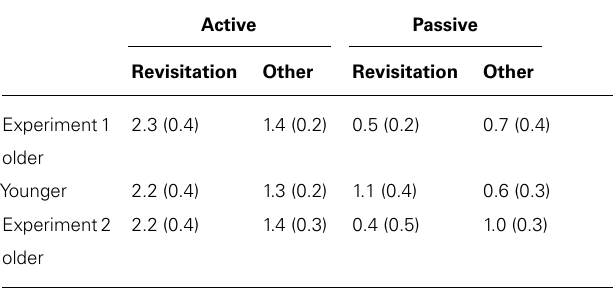
Table 3 | Mean and standard error for object-location recall placement error for objects studied with revisitation versus other-studied objects in Experiment 1 and Experiment